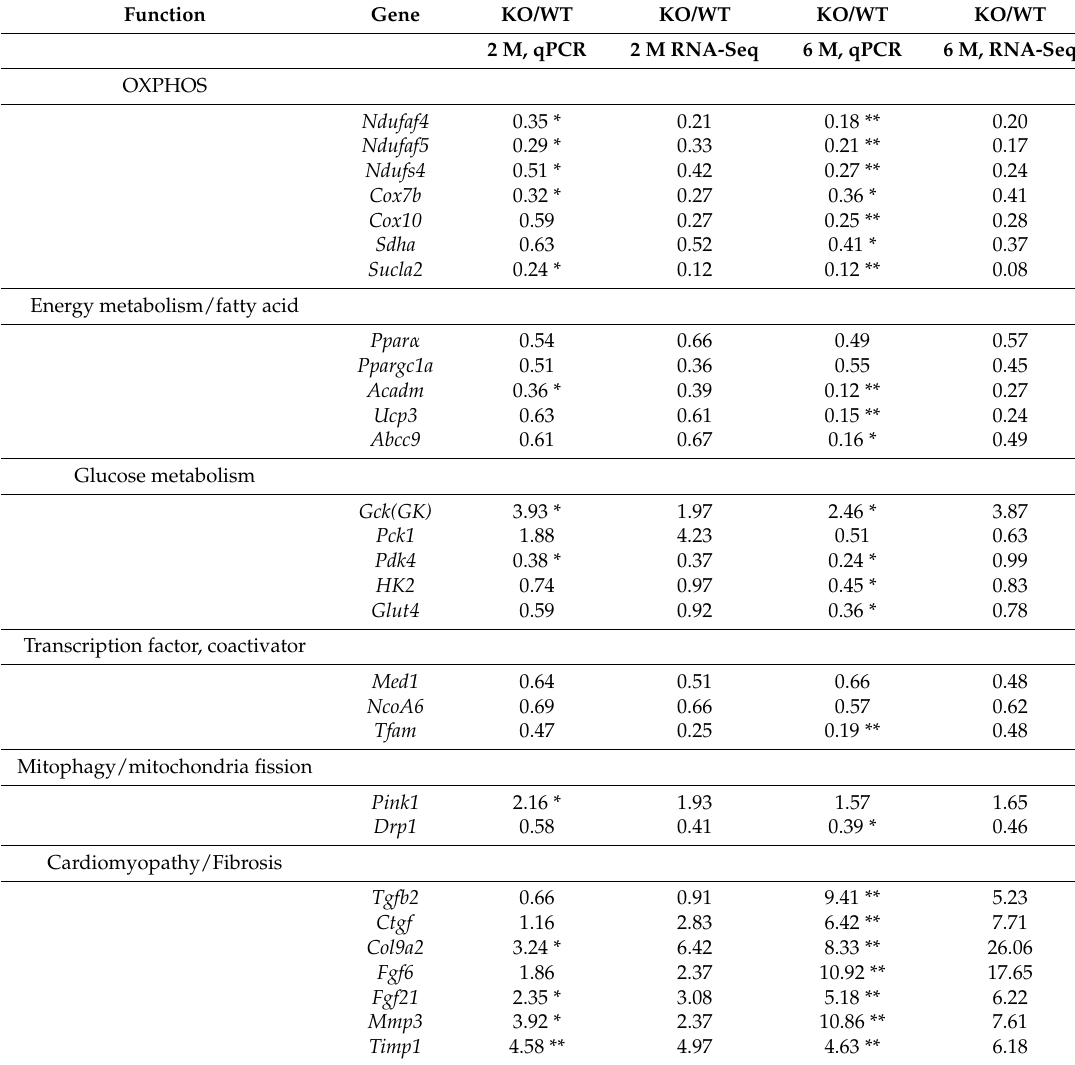
Table 1. Gene expression changes in csPIMT − / − relative to PIMT fl/fl mouse heart. Function